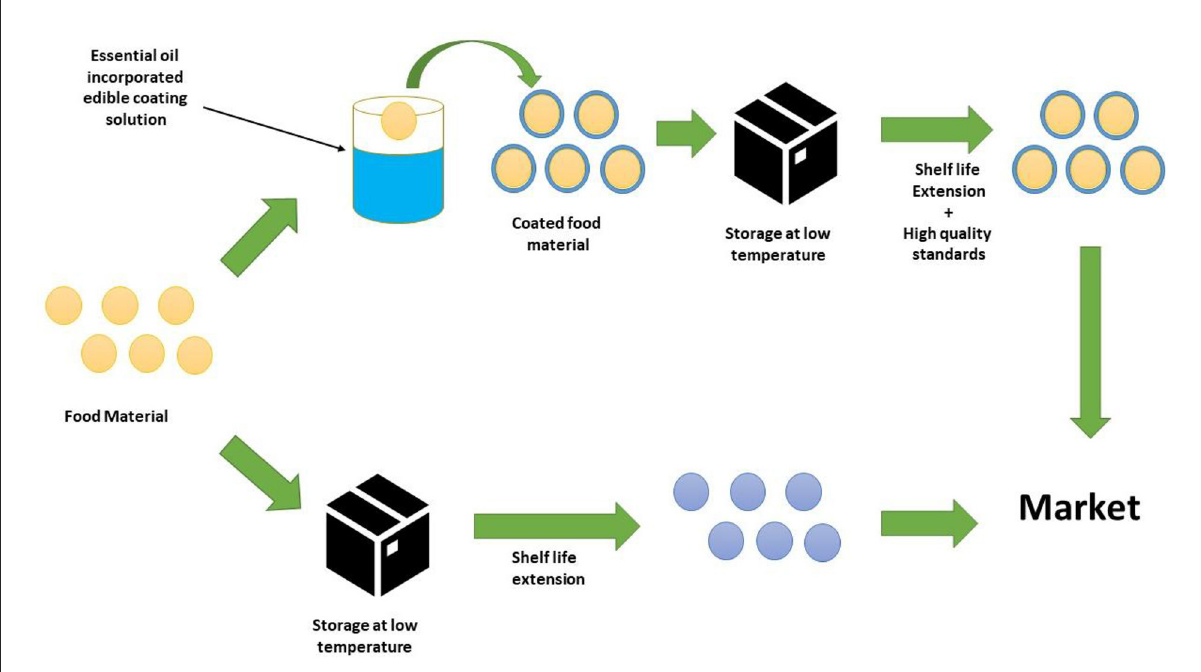
FIGURE12 Coating with essential oil incorporated edible coating